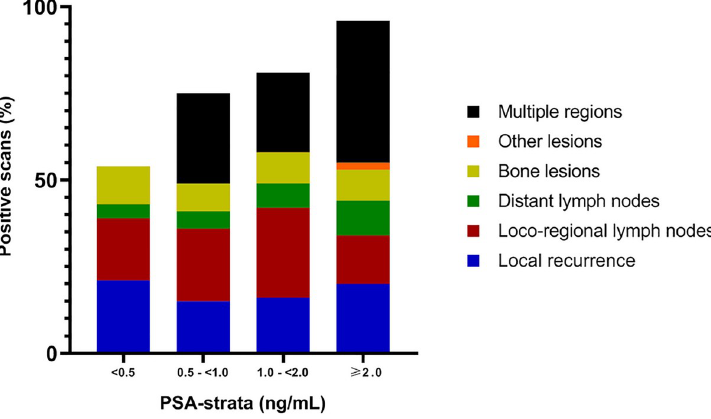
Fig 2. Detection rate 18 F-DCFPyL PET/CT per PSA-strata, including localization of PET-positive lesions.